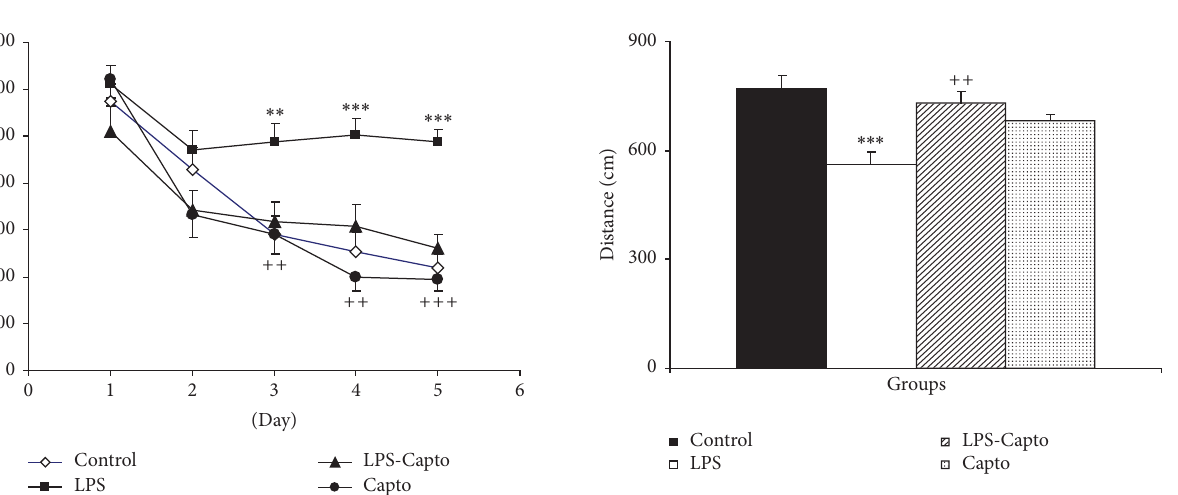
Figure 5: The results of the distance traveled in the target quadrant (Q1) in probe day, 24 hours after the last learning session. The platform was removed and the distance traveled in the target quadrant was compared between the groups. Data are shown as mean ± SEM ( 𝑛 = 10 in each group). ∗∗∗ 𝑃 < 0.001 compared with the control group and ++ 𝑃 < 0.01 compared with the LPS